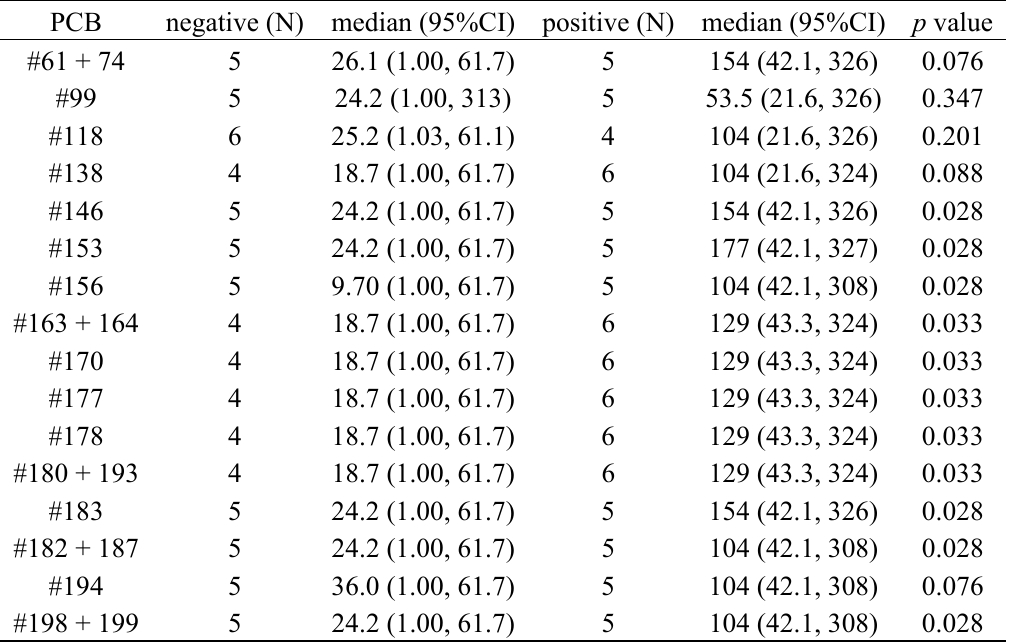
Table 4. Association between milk specific IgE and IL-22 by individual PCBs high concentration group.